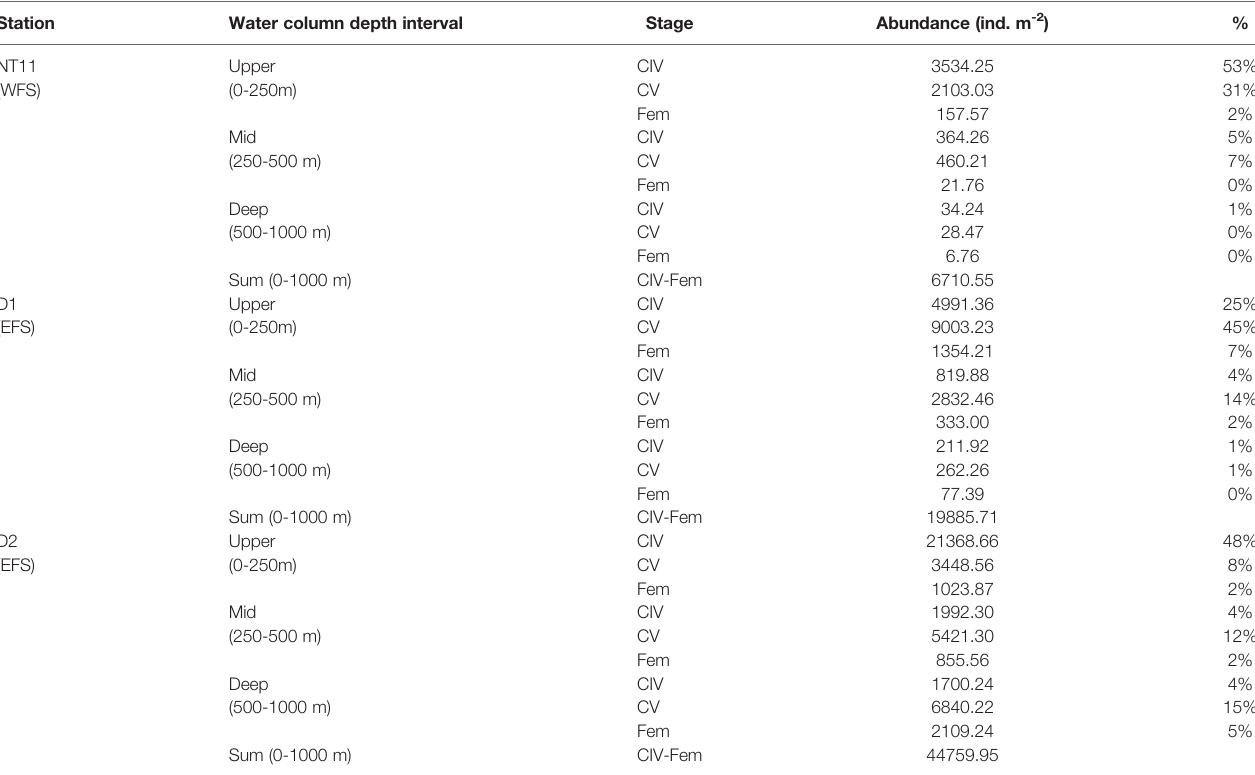
Samples from the eight 125 m depth intervals have been merged to derive three major depth